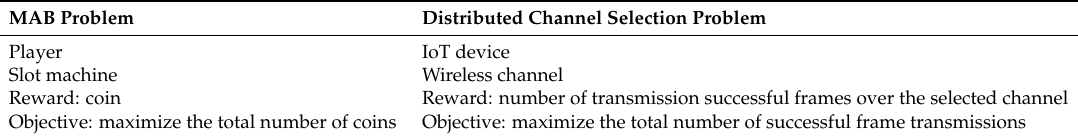
Table 1. Channel selection problem as the multi-armed bandit (MAB)